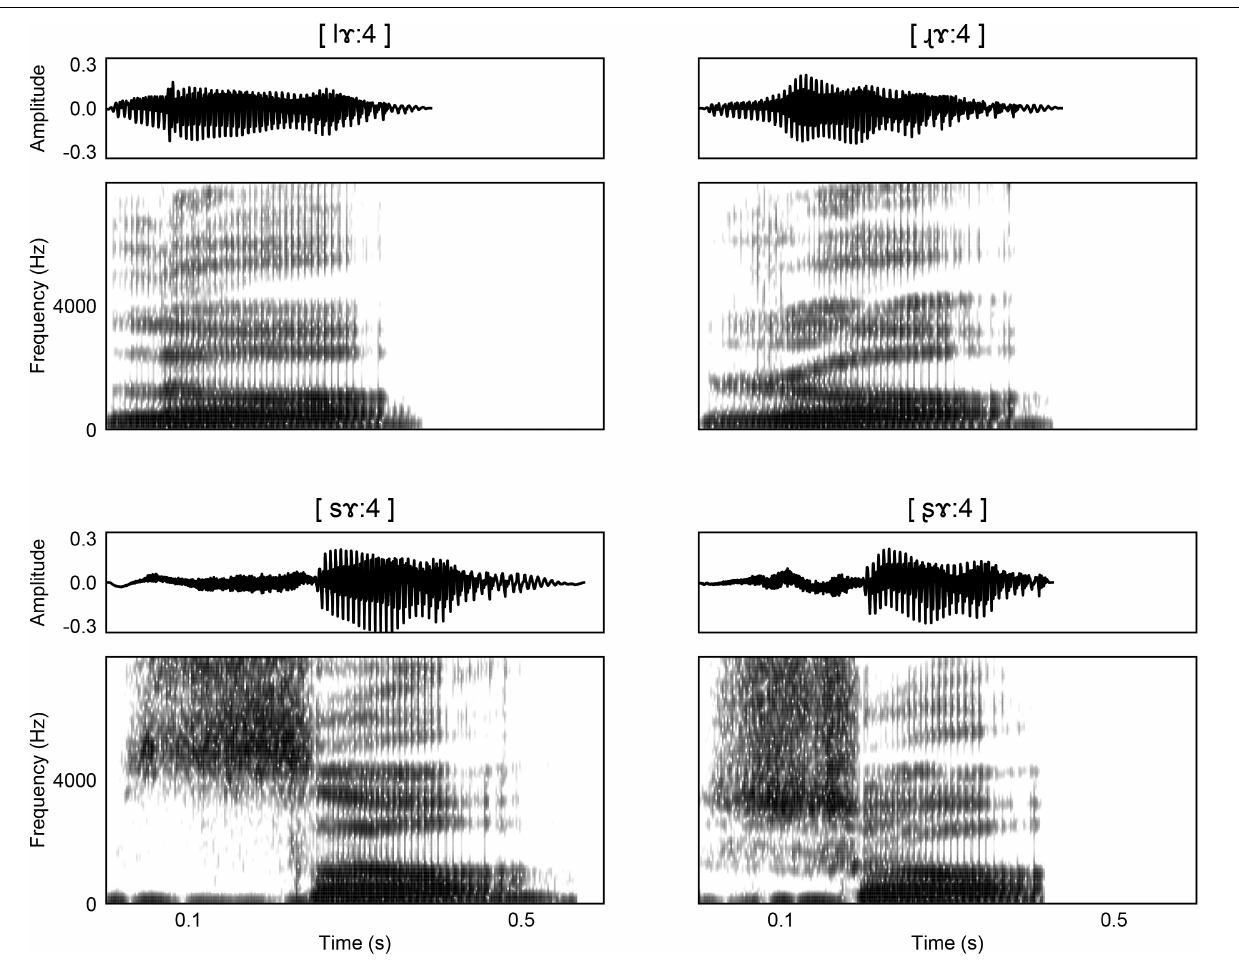
FIGURE 1 | Waveforms and spectrograms for the (top) approximant pair [ l 7: 4]/[ 7: 4] and the (bottom) fricative pair [ s 7: 4]/[ ù7: 4].